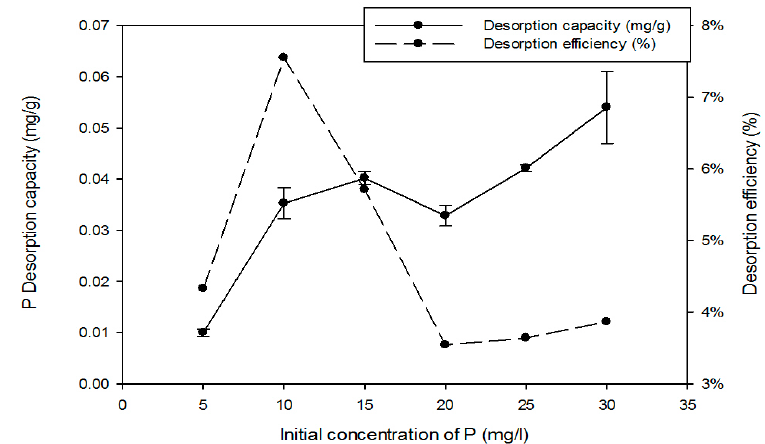
Figure 8. P desorption of concrete on different initial P concentration. Contact time 24 h; agitator 180-rpm; pH-5.